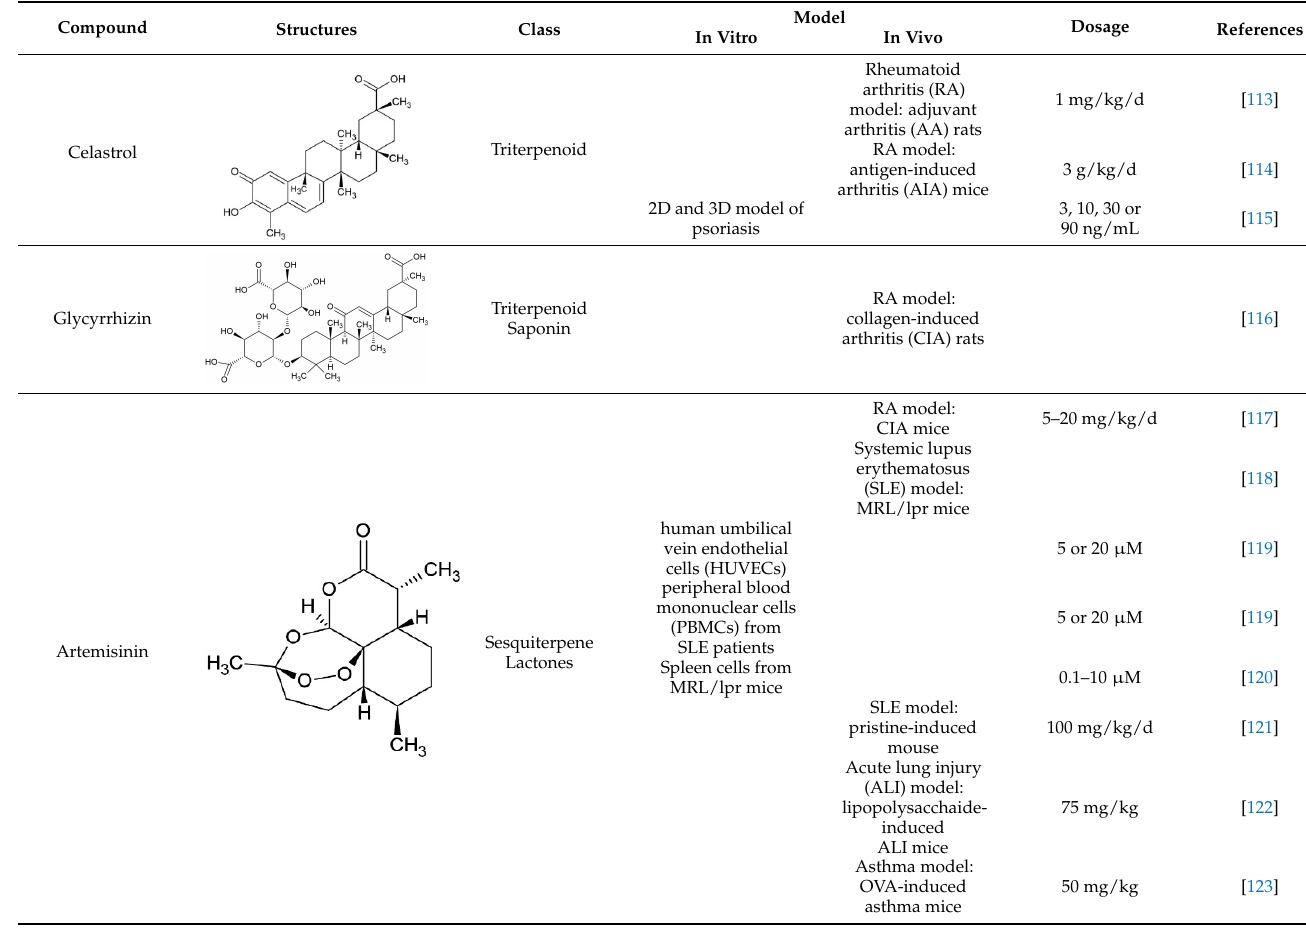
Table 2. Natural products tested in animal models of autoimmune diseases.